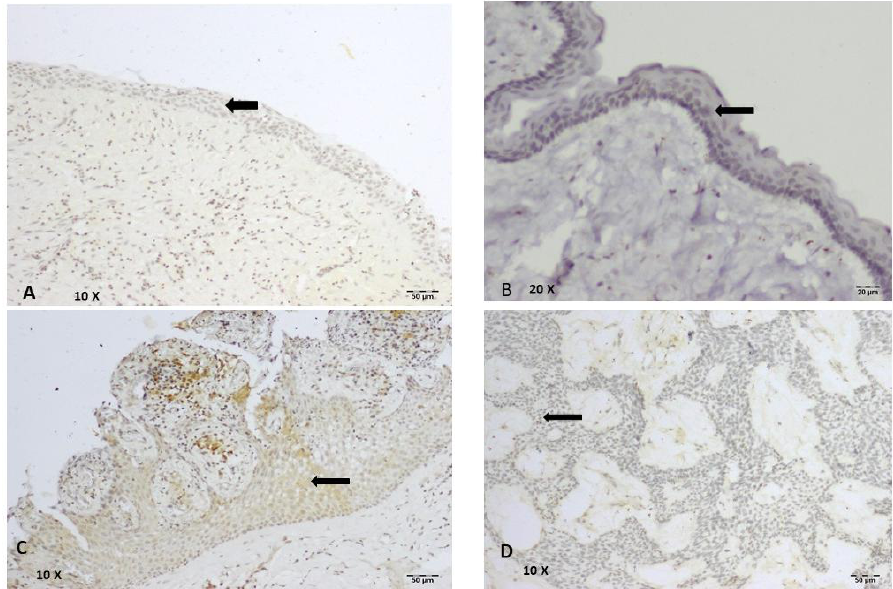
Fig 1. Expression of COX-2 in A . Dentigerous cyst, B . Odontogenic Keratocyst C . Radicular Cyst, D . Unicystic Ameloblastoma.